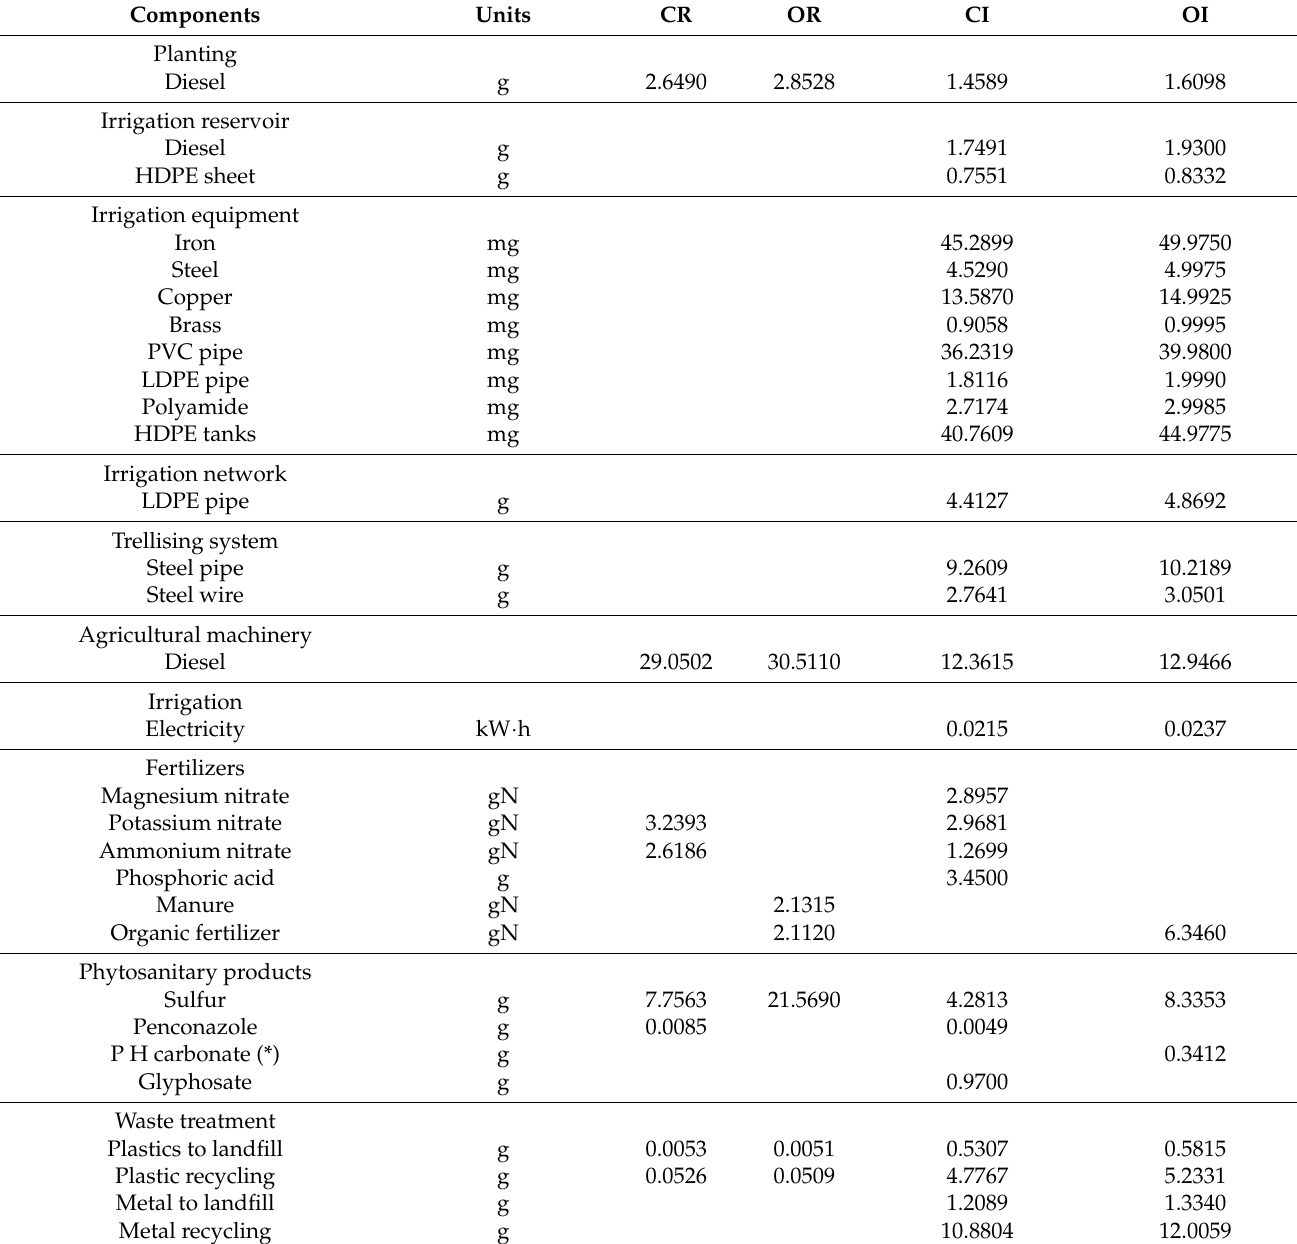
Table 3. Life cycle inventory of primary data of the four types of vineyard in relation to the functional unit (1 kg of